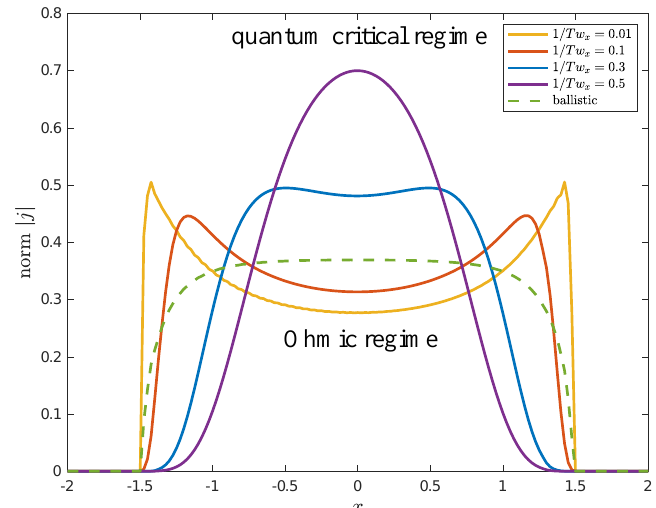
Figure 2: Simulated examples of current flow at zero density through a slit = 3 µ m and w = 0.04 µ m. The distribution evolves from doubly of w x y peaked in the Ohmic regime to singly peaked at the center in the quantum critical regime. The “kinetic" prediction for physics on length scales smaller than Planckian, (cid:96) = (cid:96) (cid:29) w (known as the ballistic limit), is further shown in the dashed green x ee mr